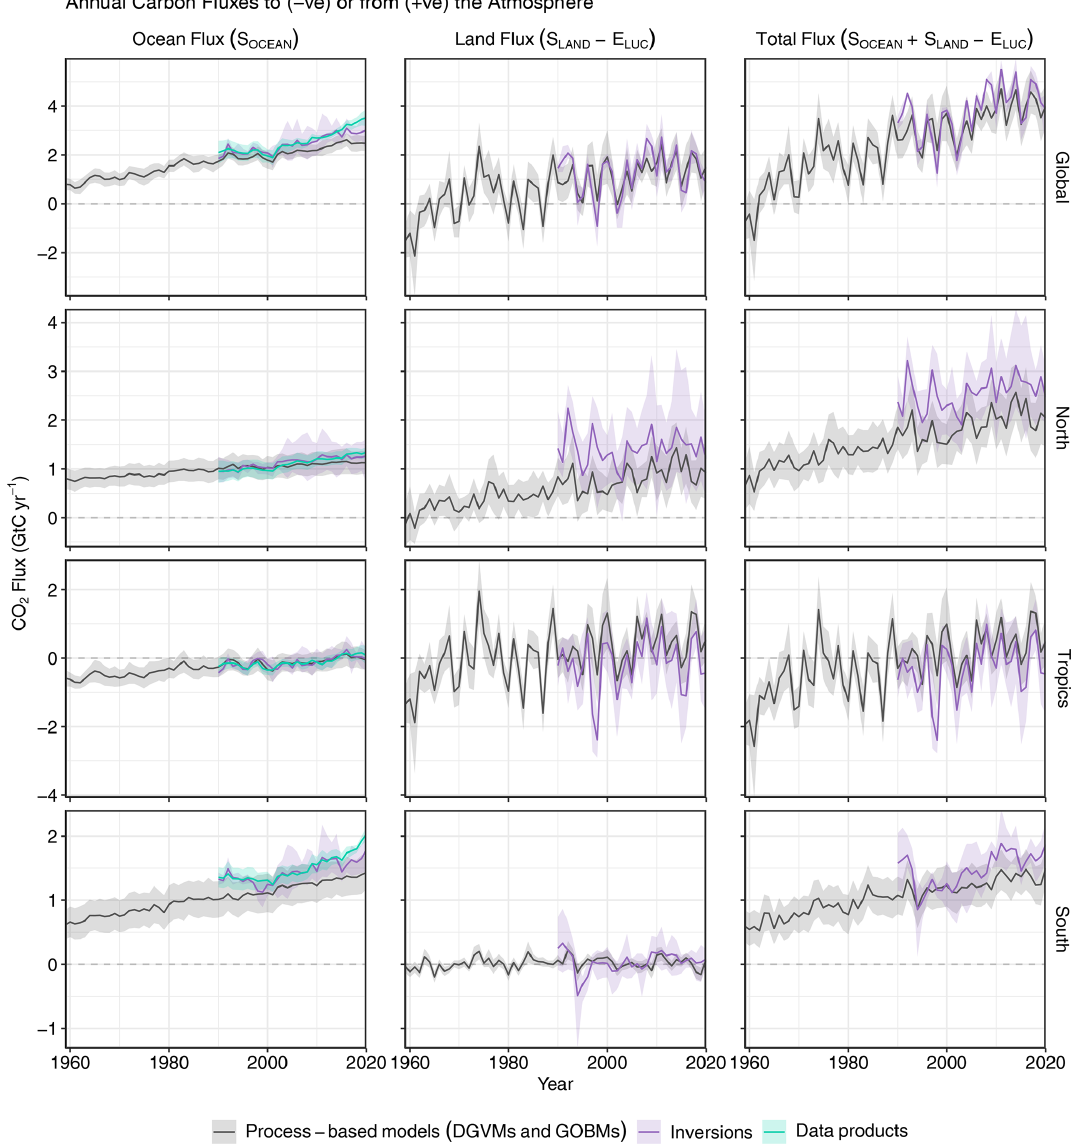
Figure 12. CO 2 fluxes between the atmosphere and the Earth’s surface separated between land and oceans, globally and in three latitude bands. The ocean flux is S OCEAN and the land flux is the net atmosphere–land fluxes from the DGVMs. The latitude bands are (top row) global, (second row) north ( > 30 ◦ N), (third row) tropics (30 ◦ S–30 ◦ N), and (bottom row) south (<30 ◦ S), and over ocean (left column), over land (middle column), and total (right column). Estimates are shown for process-based models (DGVMs for land, GOBMs for oceans), inversion models (land and ocean), and f CO 2 -based data products (ocean only). Positive values indicate a flux from the atmosphere to the land or the ocean. Mean estimates from the combination of the process models for the land and oceans are shown (black line) with ± 1 standard deviation (1 σ ) of the model ensemble (grey shading). For the total uncertainty in the process-based estimate of the total sink, uncertainties are summed in quadrature. Mean estimates from the atmospheric inversions are shown (purple lines) with their full spread (purple shading). Mean estimates from the f CO 2 -based data products are shown for the ocean domain (light blue lines) with their ± 1 σ spread (light blue shading). The global S OCEAN (upper left) and the sum of S OCEAN in all three regions represents the anthropogenic atmosphere-to-ocean flux based on the assumption that the pre-industrial ocean sink was 0GtCyr − 1 when riverine fluxes are not considered. This assumption does not hold at the regional level, where pre-industrial fluxes can be significantly different from zero. Hence, the regional panels for S OCEAN represent a combination of natural and anthropogenic fluxes. Bias correction and area weighting were only applied to global S OCEAN ; hence the sum of the regions is slightly different from the global estimate ( < 0.06GtCyr − 1